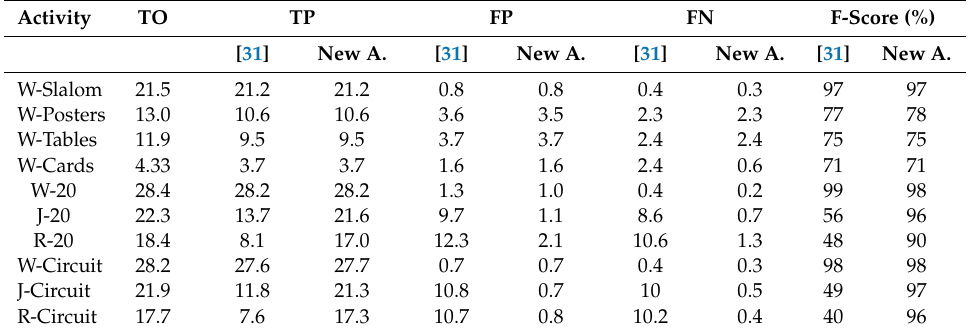
Table 5. Average results of TO detection for each type of activity performed by the 56 participants in the FAU dataset using the previous and the proposed TO detection algorithms.